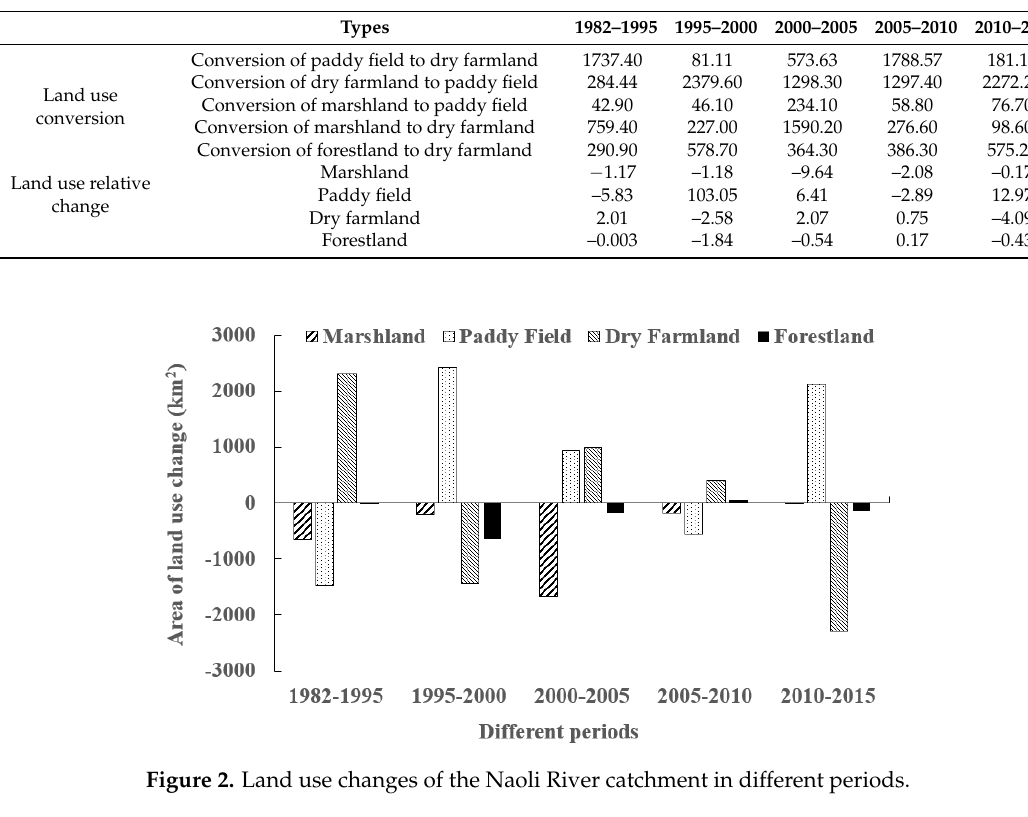
Table 3. Land use conversion and relative change in different periods (km 2 , %).